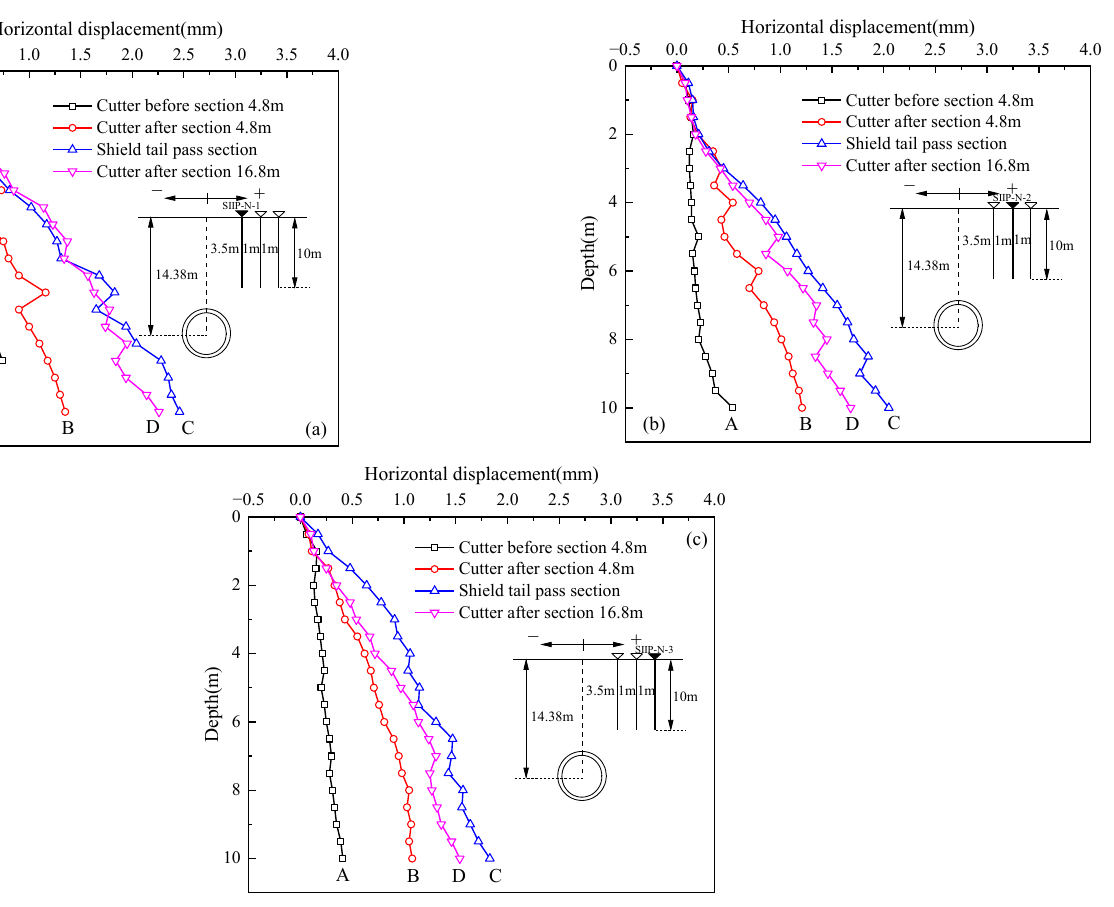
Figure 12. Horizontal displacement of stratum soil in monitoring section B: ( a ) SIIP-N-1; ( b ) SIIP-N-2; and ( c ) SIIP-N-3.